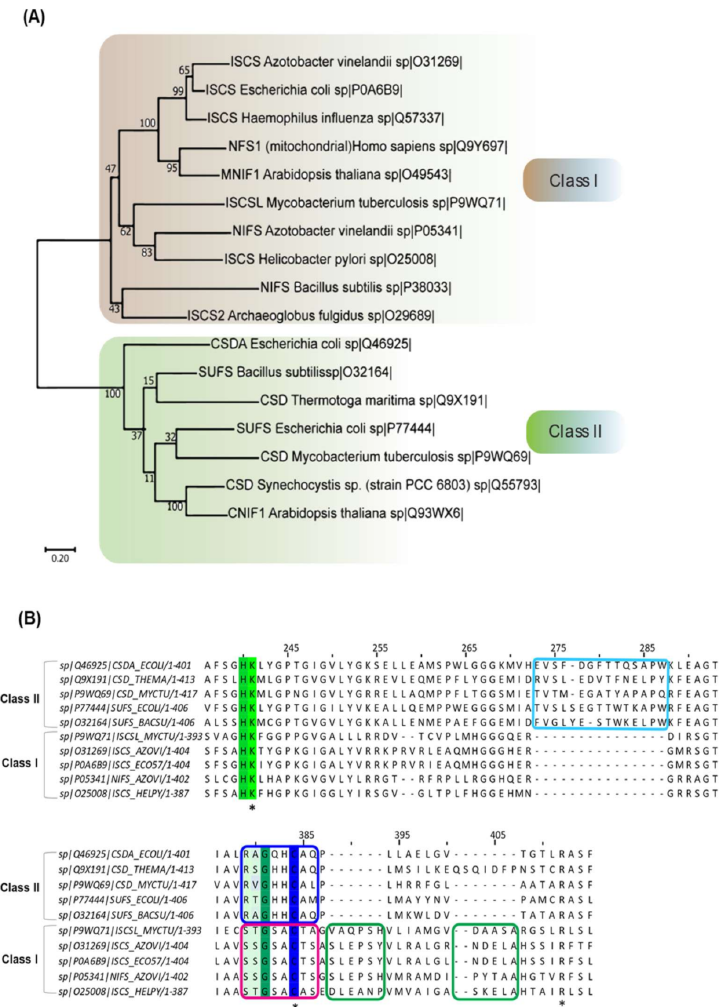
Figure 1. Phylogenetic analysis of CSD enzymes of organisms from different domains. ( A ) Maximum likelihood phylogenetic reconstruction of 17 CSD homologs from organisms spanning throughout three domains: Eukarya, Bacteria, and Archaea. Evolutionary analysis performed in MEGA X [42]. The CSD homologs are seen to cluster into two main branches, which can be determined as Class I and II. This tree has a maximum log-likelihood of − 13398.96. The scale bar shows genetic distance. Bootstrap values (500 replicates) shown next to the branches. ( B ) Multiple sequence alignment of different bacterial CSD homologs. CSDs are indicated as UniProt ID. The green-highlighted lysine (K)-residue is the highly conserved PLP-coordinating residue, while the cyan box highlights the sequence insertion acquired by the Class II CSDs. The green boxes focus on the sequence insertion inherent to the Class I CSDs, whereas the blue and pink box features the differences in the sequences adjacent to the active site cysteine. Conserved lysine, cysteine and arginine residue are indicated by